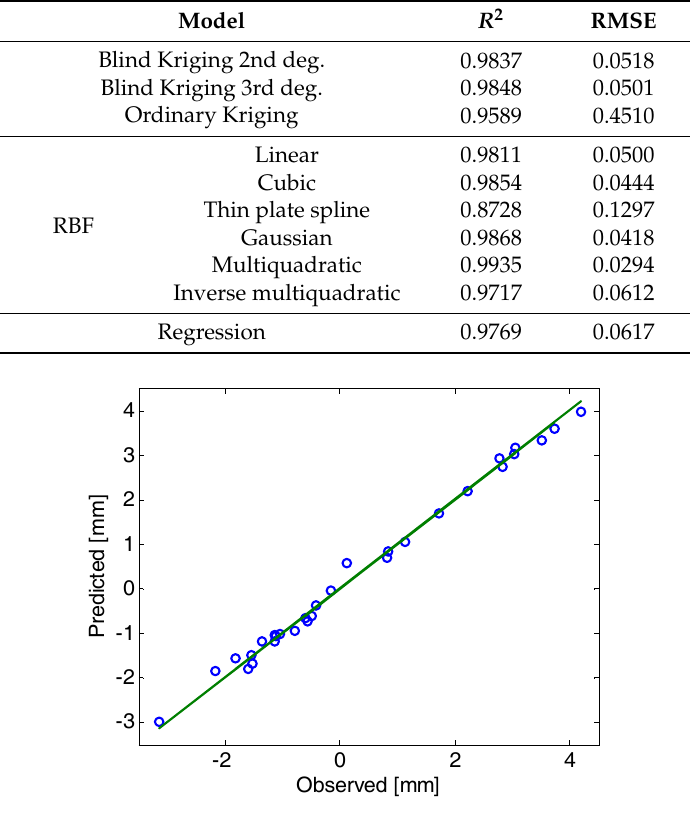
Figure 9. Predicted vs. observed result for RBF with multiquadratic basis function.